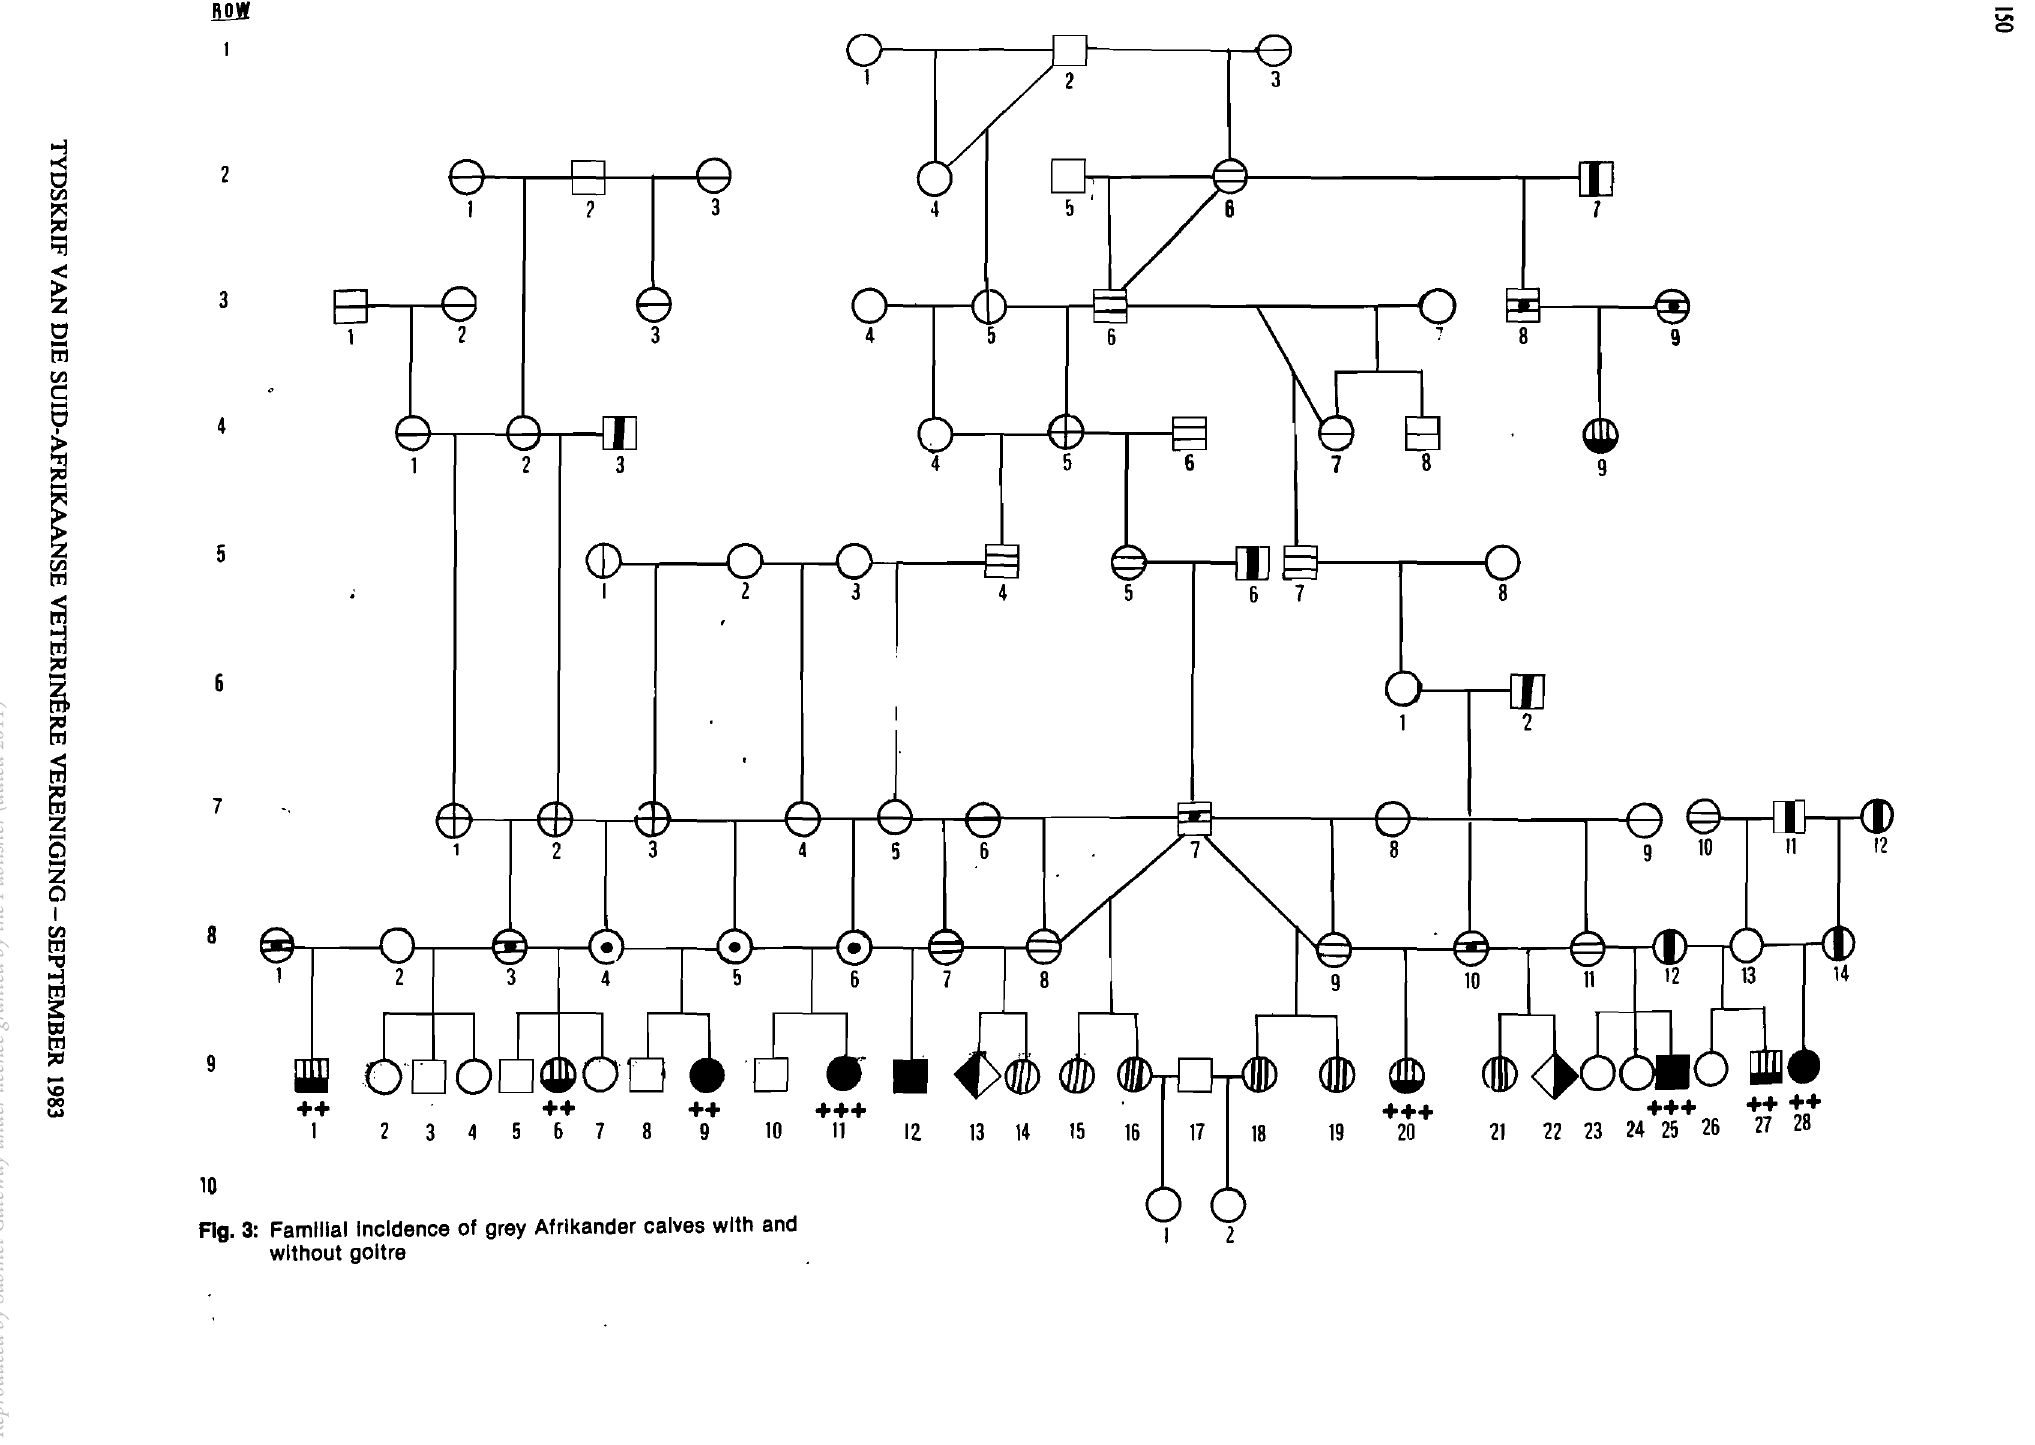
FIg. 3: FamIlial Incidence of grey Afrlkander calves with and without